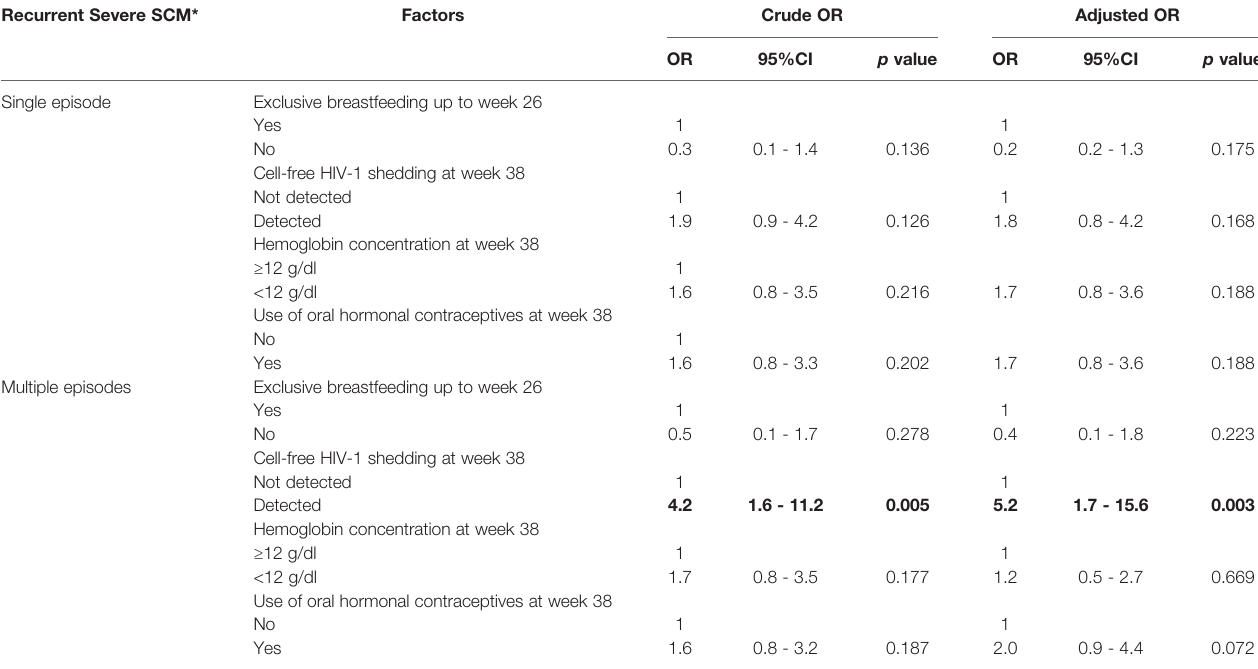
TABLE 4 | Effect of recurrent severe sub-clinical mastitis (SCM) on cell-free viral (CFV) shedding in breast milk. Recurrent Severe